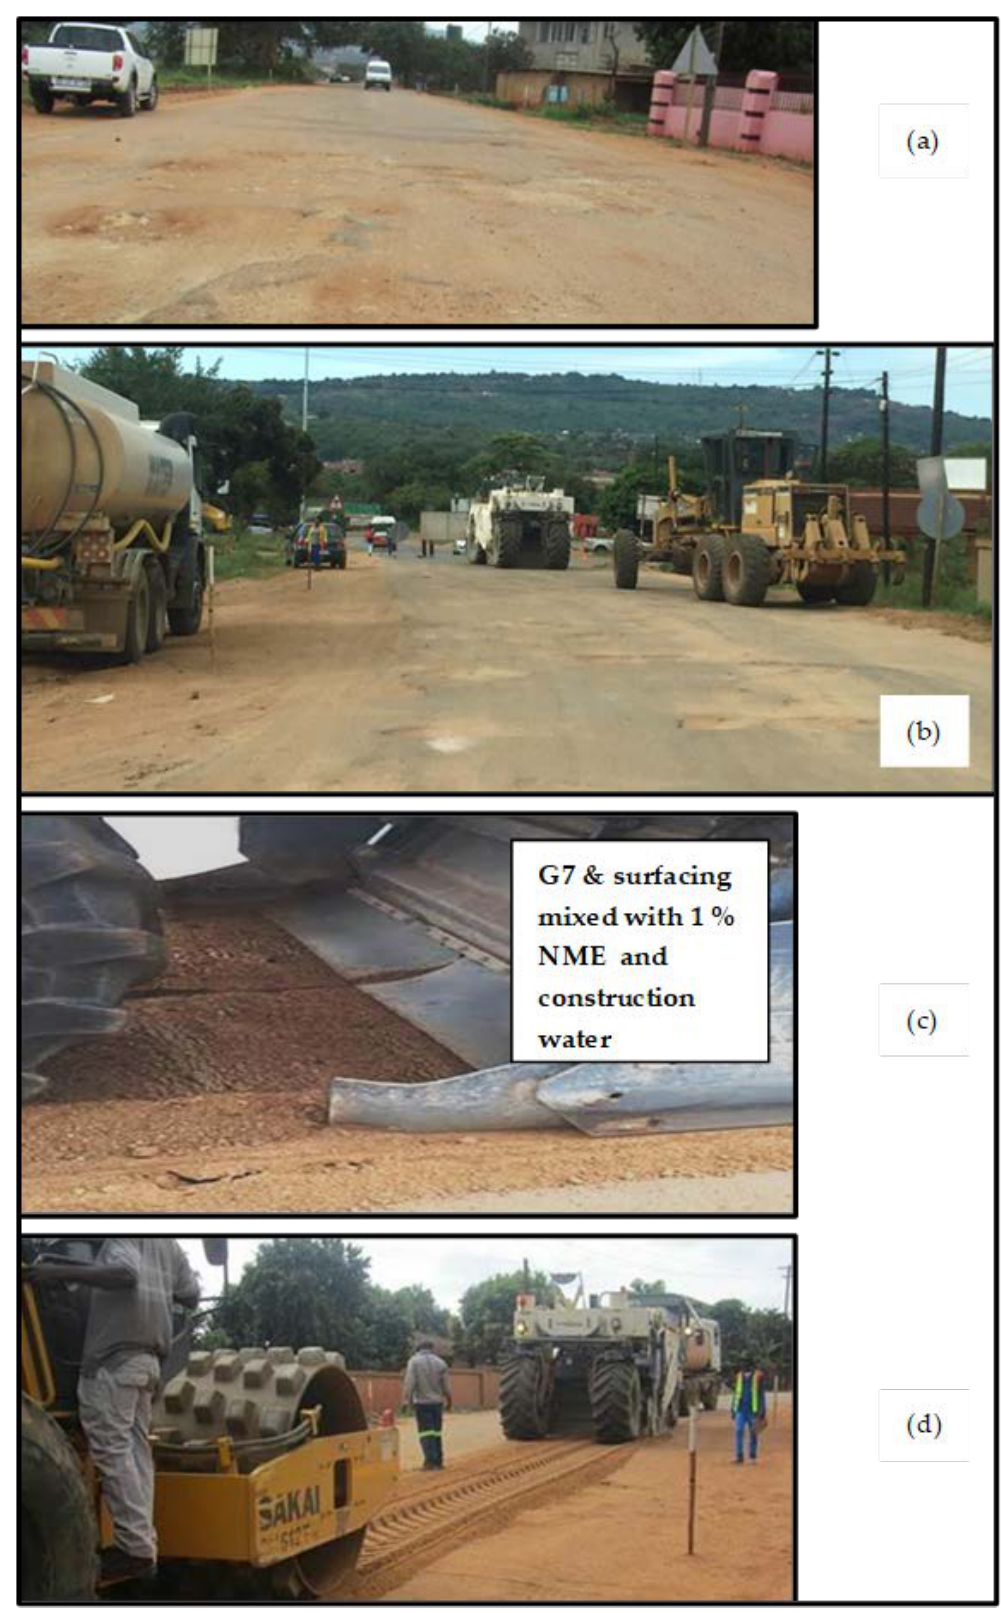
Figure 11. ( a , b ) Rehabilitation of a severely distressed urban road. ( c , d ) Mixing the surfacing with the in situ G7-quality base material with 1.0% NME material-compatible stabilising agent within the construction water and the compaction to be opened to local traffic the same day.